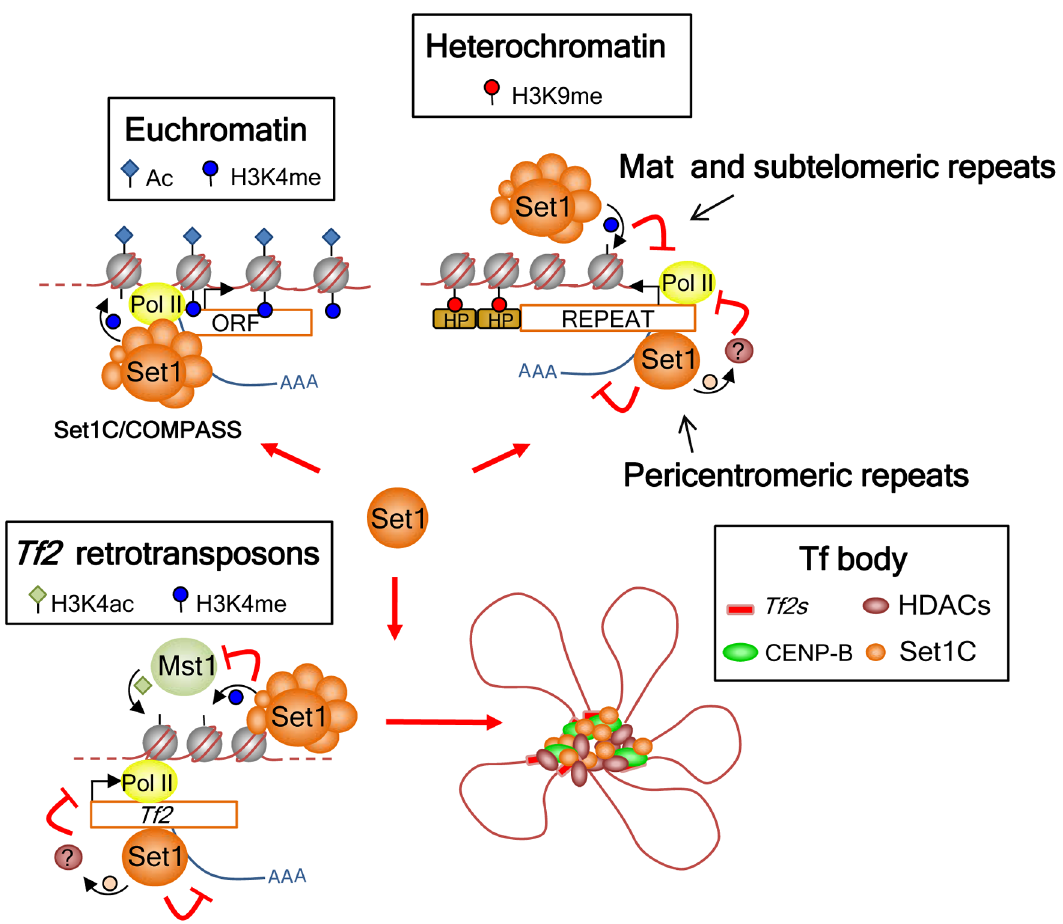
Figure 7. Model for the roles of Set1C in genome control in S.pombe . Set1 exerts its multifaceted genome control at euchromatin and heterochromatin dependent and independent of H3K4 methylation and the Set1C complex. At euchromatin, Set1 operates as part of the Set1C/ COMPASS complex that is responsible for H3K4me distribution at active RNA polymerase II genes. At interspersed Tf2s and heterochromatic loci, Set1 has a repressive role mediated through two distinct pathways: H3K4me/Set1C-dependent repression at the silent mat locus and subtelomeres, and H3K4me/Set1C-independent repression at Tf2s and pericentromeric heterochromatin. Our findings also anticipate the presence of novel non-histone H3K4 substrates involved in the repression of Tf2s and pericentromeric repeats that could be partly mediated via Set1 association with Pol II nascent transcripts. In addition, Set1C and H3K4me have a distinct genome organization role at Tf2s by antagonizing the activity of the histone H3K4 acetyltransferase Mst1 to maintain the integrity of Tf bodies.